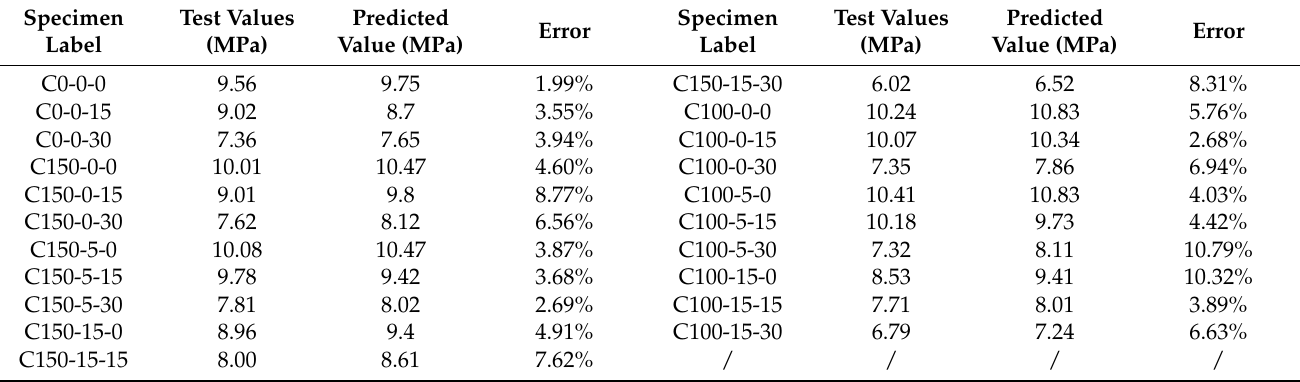
Table 9. Comparison of ultimate bond strength between experimental measurement and formula derivation.